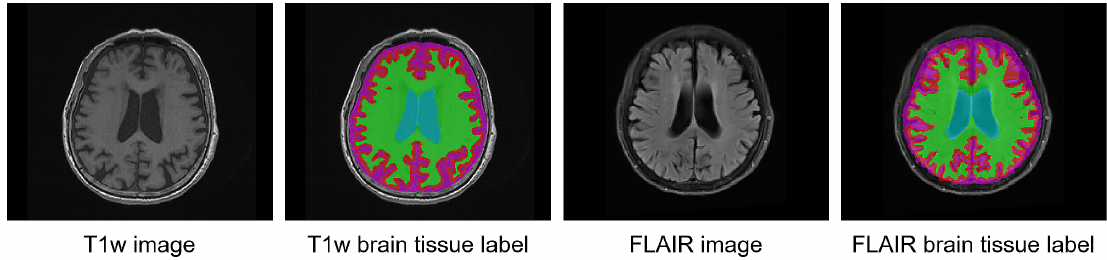
Figure 2. Example of brain tissue labels on T1w MRI and their co-registered pseudo-labels on FLAIR